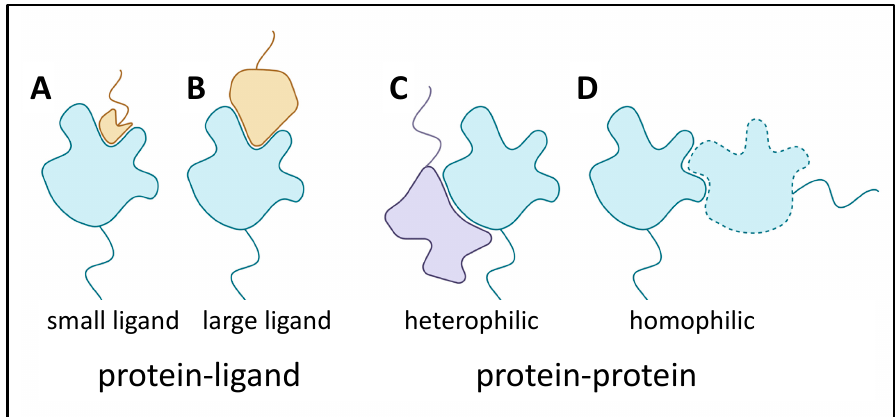
Figure 2. Adhesin binding to ligands and binding partners. Colors are the same Figure 1, with a heterophilic binding partner (lavender in C).